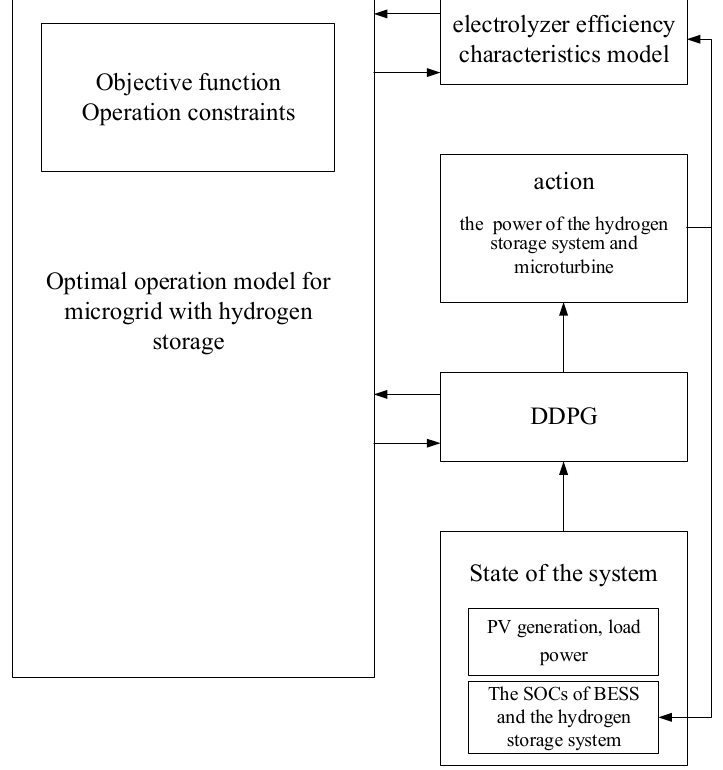
Figure 3. Block diagram of the optimal operation of the microgrid.